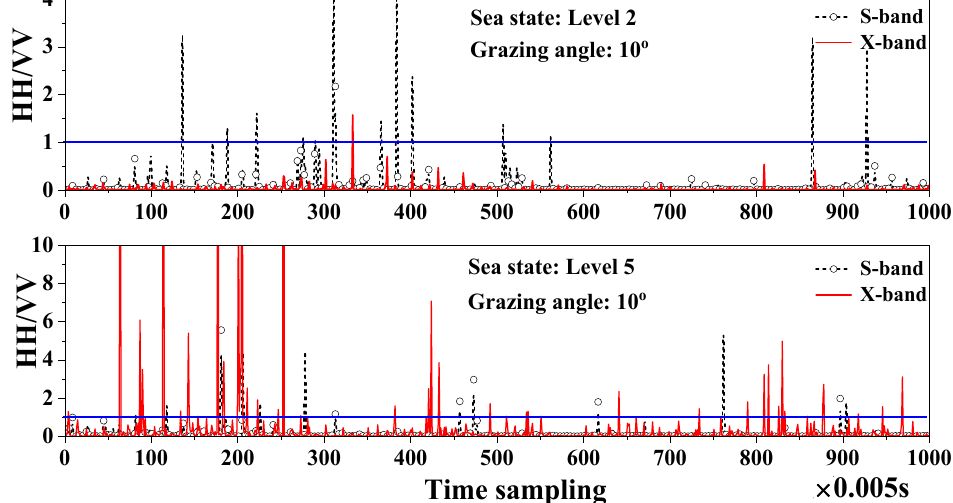
Figure 9. Amplitude mean polarization ratio of different bands under different sea conditions (HH/VV).